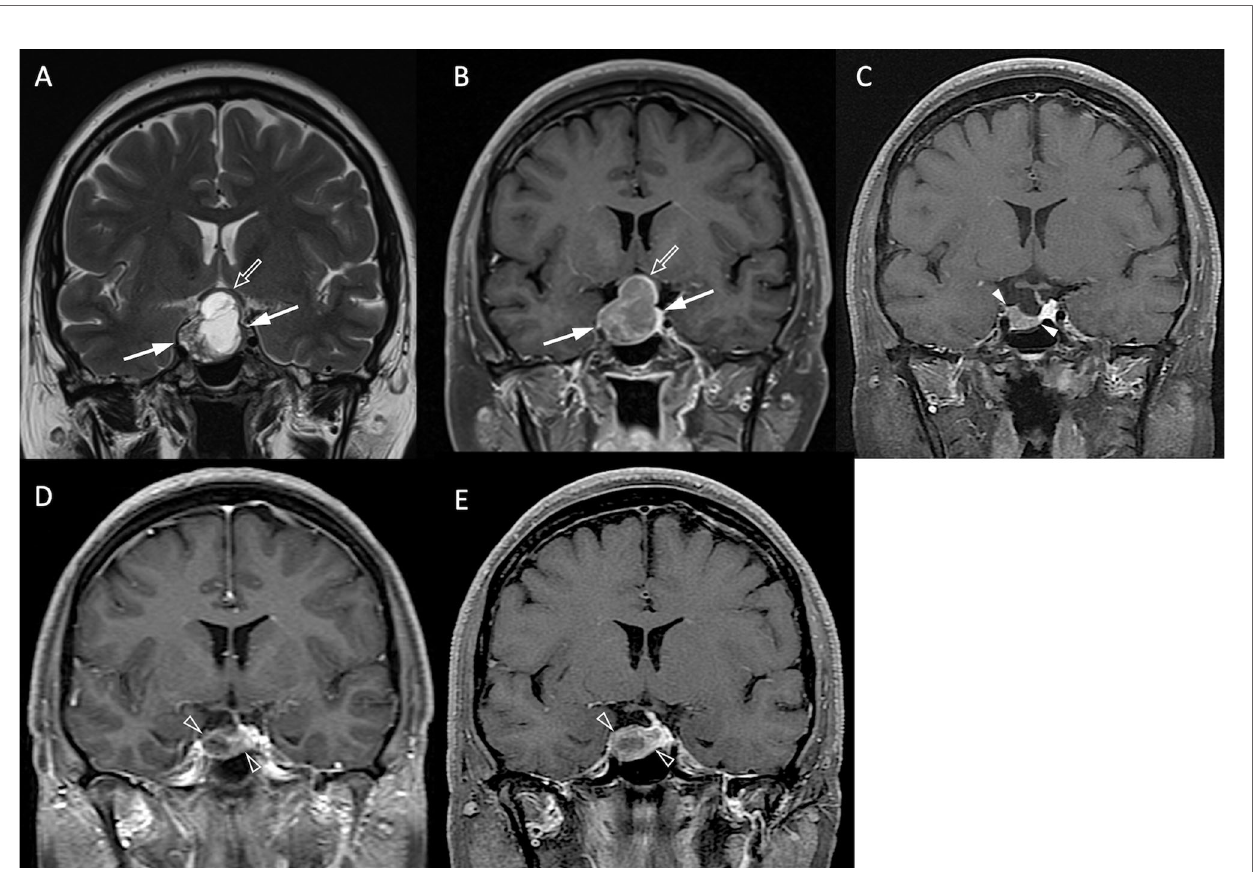
FIGURE 3 | NFPA with P/R. A 45-year-old female patient with blurred vision, headache, and pathologically con fi rmed NFMA. (A, B) Coronal T2WI (A) and CE T1WI (B) show a NFMA (white arrows) with upward suprasellar extension, causing compression of the optic chiasm and the third ventricle (open arrow). (C) Subtotal tumor resection via transsphenoidal approach (TSA) was performed, and the residual tumor (arrowheads) was observed. (D, E) Progression of the residual tumor (open arrowheads) was observed in 27 months (D) and 43 months (E) after